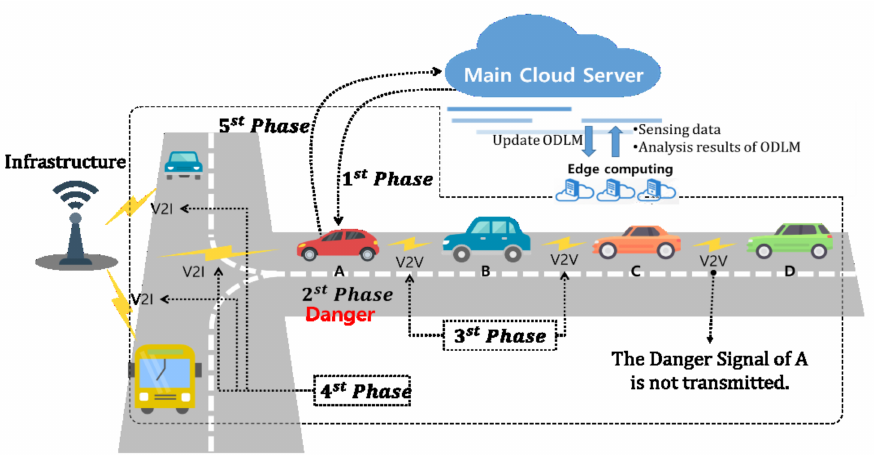
Figure 10. The structure of the V2X based Accident Notification Service